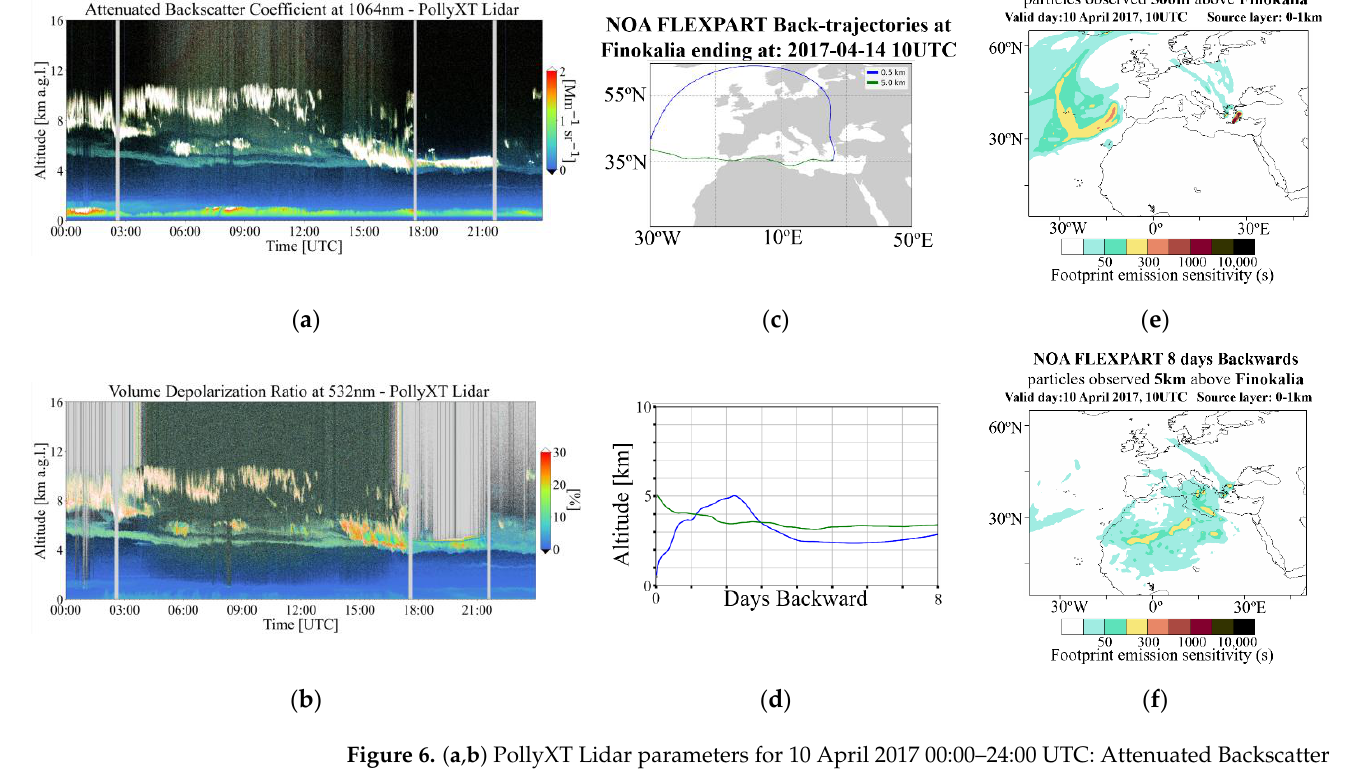
Figure 6. ( a , b ) PollyXT Lidar parameters for 10 April 2017 00:00 – 24:00 UTC: Attenuated Backscatter Coefficient at 1064 nm channel in arbitrary units (a.u.); Volume Depolarization Ratio in percentage units, ( c ) Air mass backward trajectories, based on FLEXPART simulations, ending at 0.5 (blue) and 5 (green) km above the Finokalia station on 10 April 2017 at 10:00 UTC ( d ) Altitudes, above ground level, of the air masses on their route prior their arrival over the ground station ( e , f ) FLEXPART Source – Receptor Relationships (s) for air masses originating from 0 – 1 km a.s.l. arriving above Finokalia at: 0.5 and 5 km accordingly on 10 April 2017, 10:00 UTC.